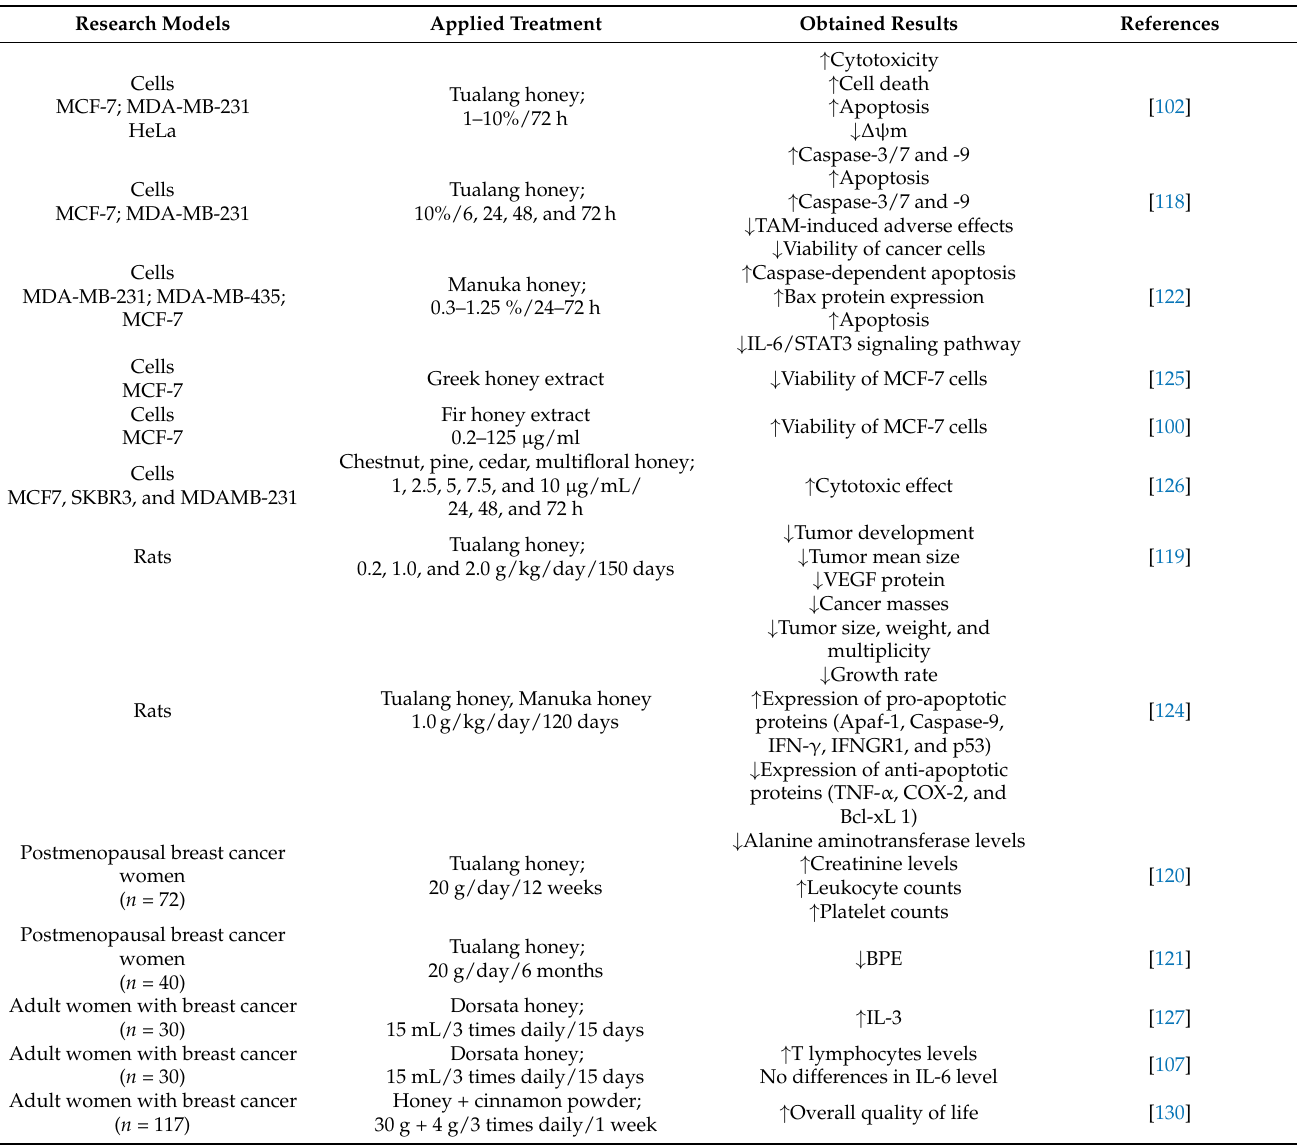
Table 2. Preclinical and clinical studies on honey’s potential against breast